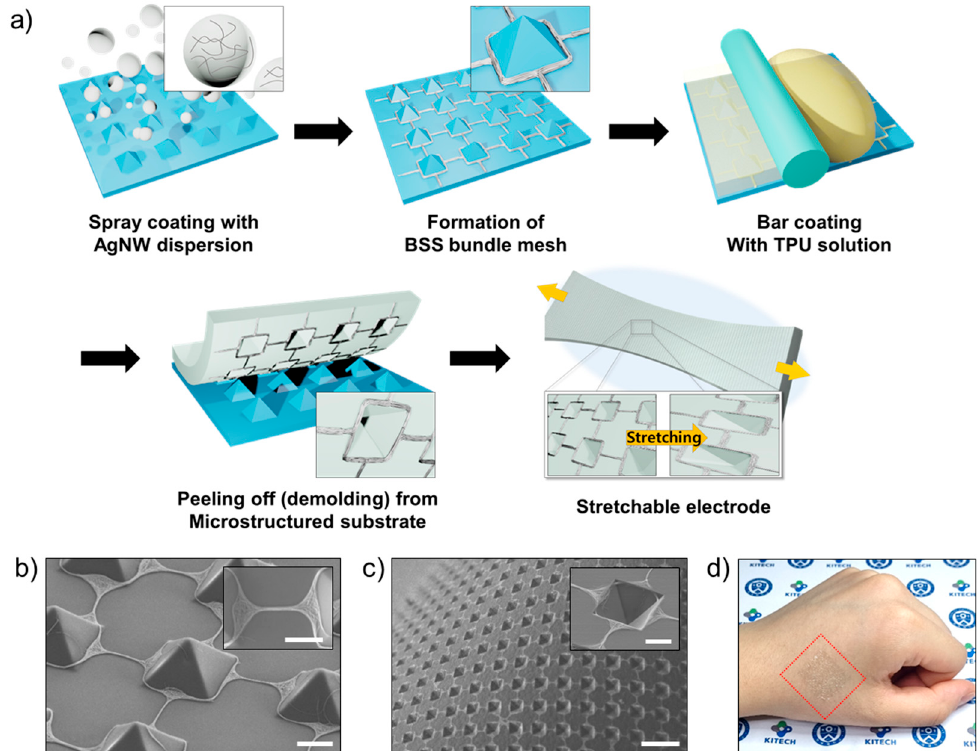
Figure 1. ( a ) Schematic of the fabrication process of the stretchable electrode. ( b ) FE-SEM images of the BSS bundle mesh after spray coating on microstructured PDMS substrate. The inset is a high-magnification image of the bridge region in the BSS mesh, where AgNW is well-aligned and packed. Scale bar: 5 µ m. ( c ) FE-SEM image of the stretchable electrode after peeling off from the microstructured substrate of Figure 1b. Scale bar: 30 µ m. The inset is a high-magnification image of a microcavity located inside a square region of the BSS mesh. Scale bar: 5 µ m. ( d ) Image of the stretchable electrode conformally attached on the back of a human hand.